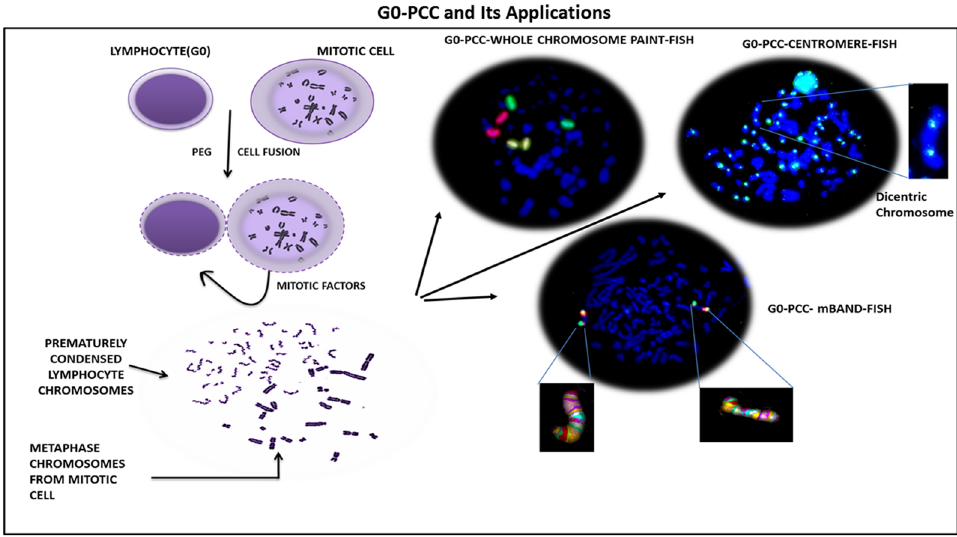
Figure 1. G 0 -PCC and its scopes for chromosomal aberration analysis with applications in